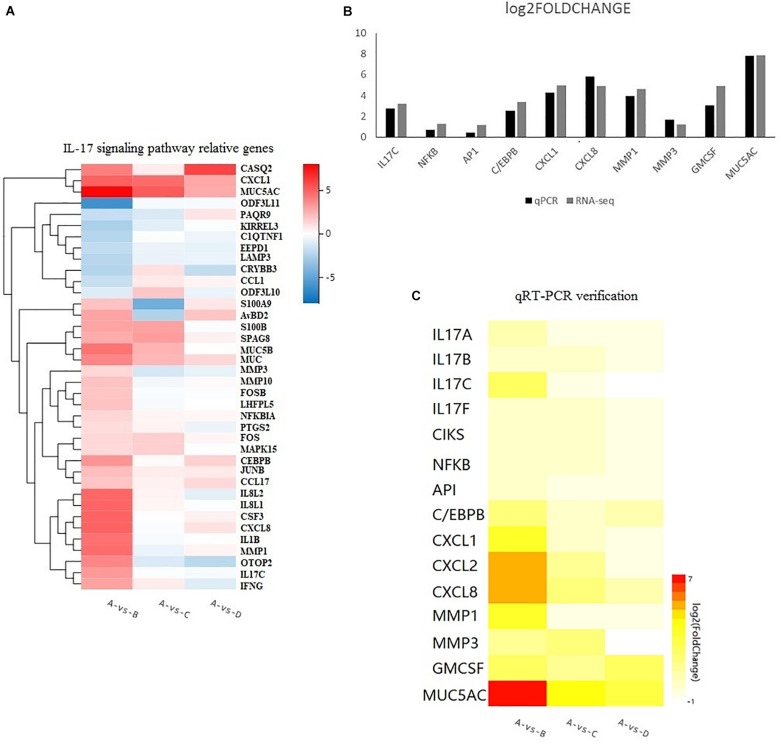
(A) Heatmap showing the relative gene expression of 38 genes responsible for the IL-17 signaling pathway according to the results of RNA-seq. The horizontal axis represents log2 fold change. The vertical axis represents the genes. A bright red color indicates stronger up-regulation and a bright blue color indicates stronger down-regulation in expression. (B) Comparison of RNA-seq and qRT-PCR results. Results are expressed as relative fold change. (C) The levels of 15 up-regulated genes from qPCR. A bright red indicates stronger up-regulation and a white color indicates no significant change in expression.